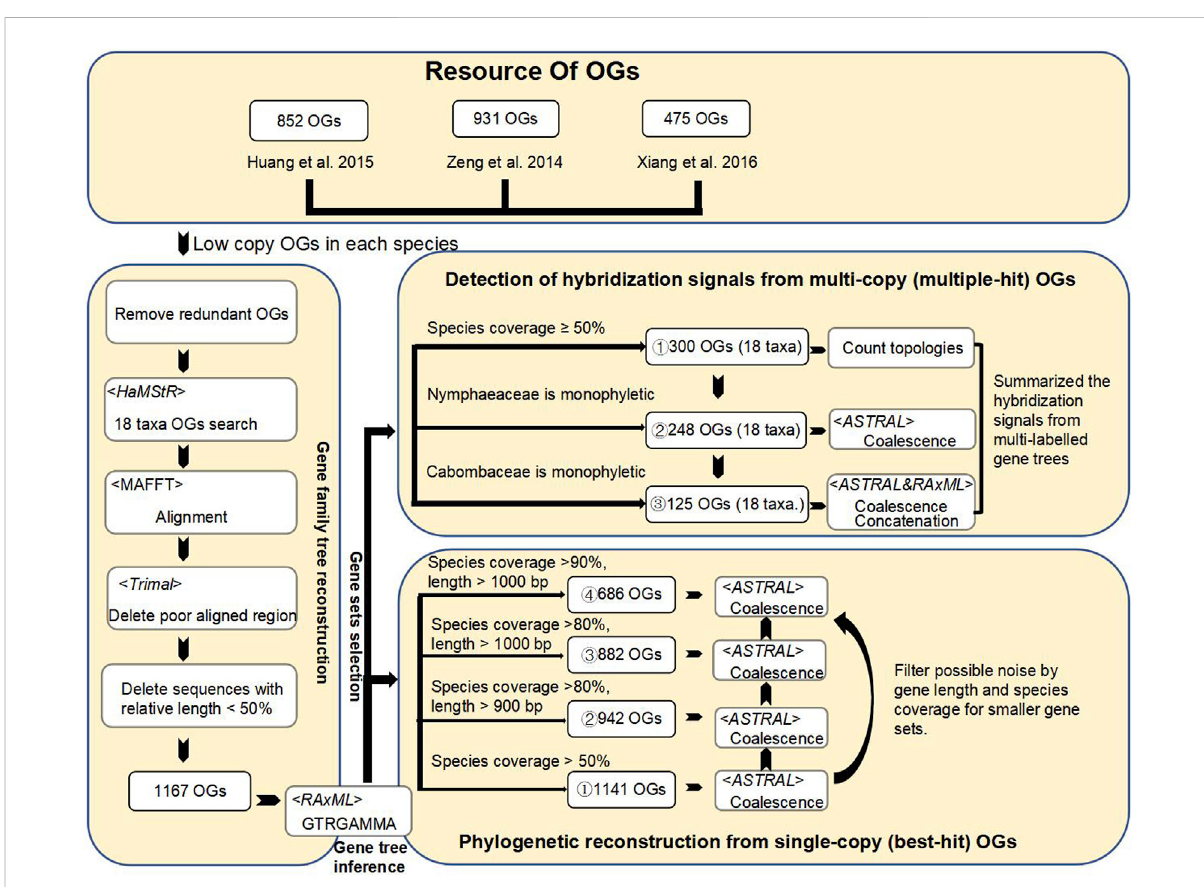
FIGURE 2 The work fl ow for orthogroups identi fi cation, fi ltering to improve phylogenetic signals and procedures to identify signals from multi-copy of orthologous gene sets forhybridization event detection. A totalof fi ltered 1,141 low-copynucleargenes fromthepreviousstudy (Zhang et al.,2020) were used to reconstruct the Nymphaeales phylogenetic framework. A total of four selected low-copy gene sets (1,141, 942, 882, and 686 OGs) by gene length and species coverage for coalescence tree analyses. The multi-copy gene set was obtained by searching for all homologs of the species corresponding to these low-copy nuclear genes. To detect hybridization signals, two multi-labeled gene sets (248 and 125) were selected based on the presence of genes from outgroup Amborella ), monophyly in the family (Nymphaeaceae and Cabombaceae) and species coverage in majorphylogeneticgroups.Finally,thehybridizationsignalsweresummarizedintoaspeciestreebythecoalescentmethodfrommulti-labeledgene family trees with 17 sampled water lilies and one